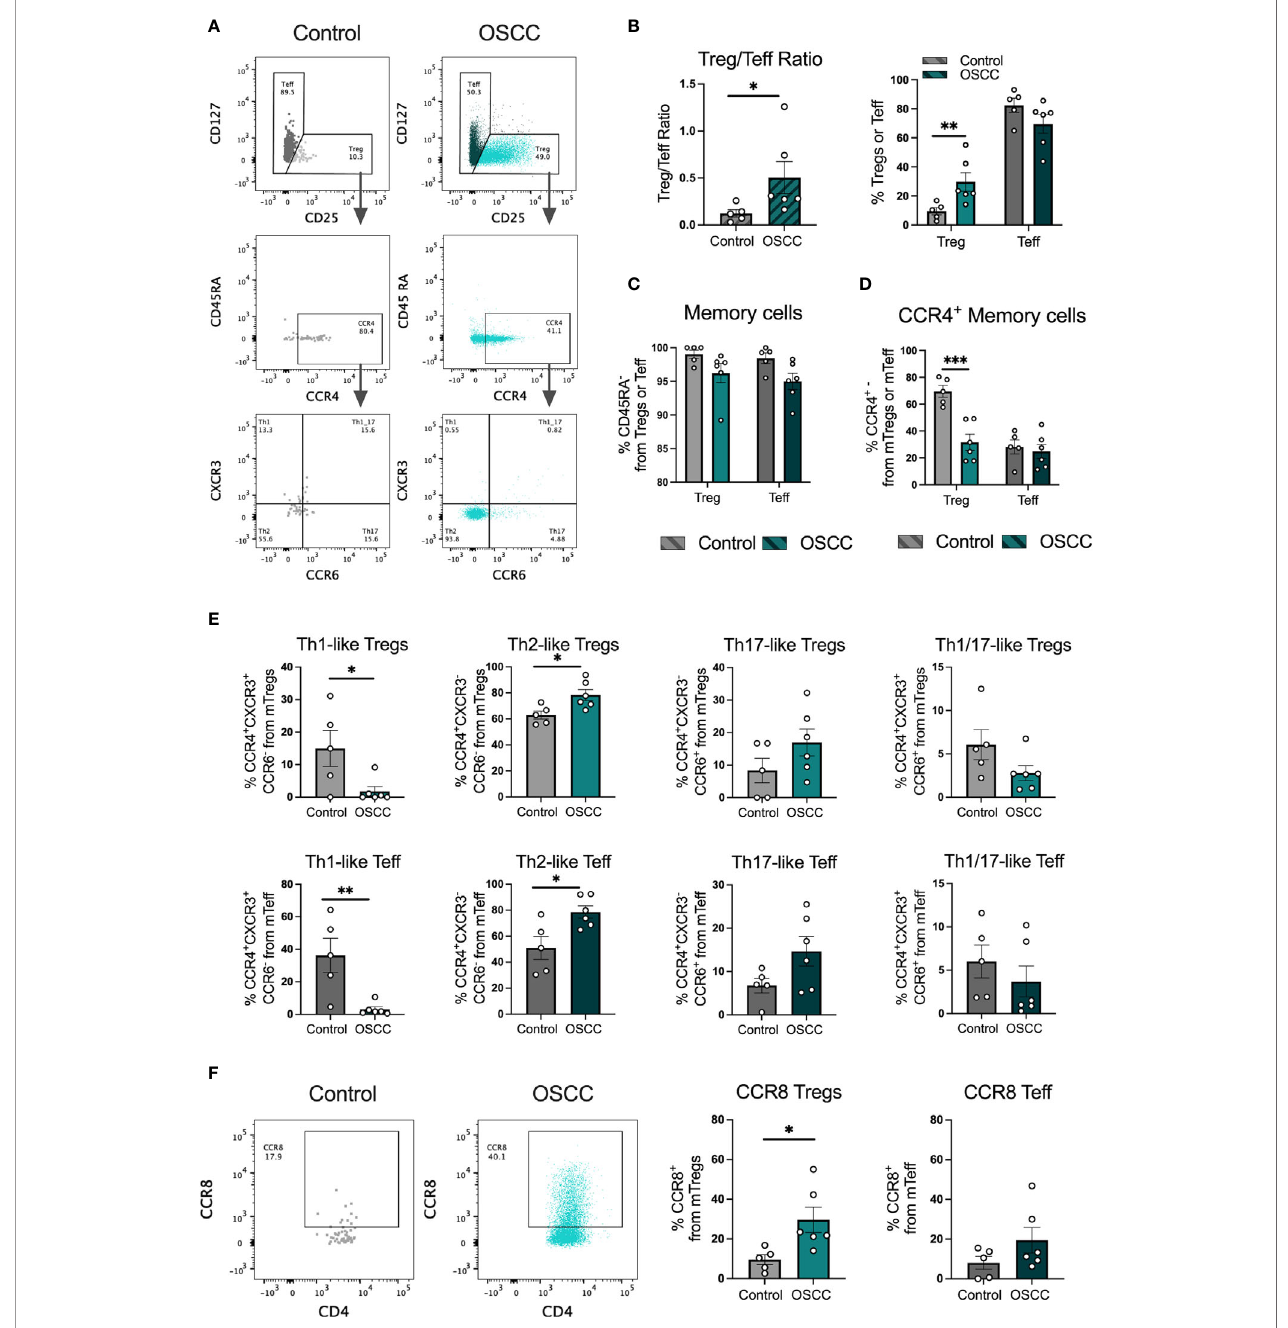
FIGURE 1 | Th2-like T cell subsets and CCR8 + Tregs are the main tumor in fi ltrating Th subsets in OSCC. (A) Representative dot plots of tissue-resident cells obtained from a biopsy from a patient with OSCC and a control patient without malignancy. CD4 + T cells were divided into Teff and Tregs using CD25 and CD127 staining. Then, memory cells were selected as CD45RA - and CCR4 and CCR8 expression was evaluated within the memory population. Within the CCR4 + subsets, Th1 were de fi ned as CXCR3 + CCR6 - , Th2 as CXCR3 - CCR6 - , Th17 as CXCR3 - CCR6 + and Th1/17 CXCR3 + CCR6 + . (B) Comparison of the Treg/Teff ratio and percentages of Tregs and Teff between OSCC patients and patients without malignancy. (C) Comparison of memory Tregs and Teff between OSCC patients and patients without malignancy. (D) Comparison of CCR4 expression within the memory Treg and Teff population between OSCC patients and patients without malignancy. (E) Comparison of tissue resident memory CCR4 + Th-like Tregs and Th-like Teff between OSCC patients and patients without malignancy. (F) Representative dot plots and comparison of CCR8 expression within the memory Treg and Teff population OSCC patients and patients without malignancy. Data are presented as mean ± SEM using bars with scatter dot plots (Unpaired t test). For all statistical tests, ∗∗∗ p < 0.001, ∗∗ p < 0.01 and ∗ p < 0.05 were considered signi fi